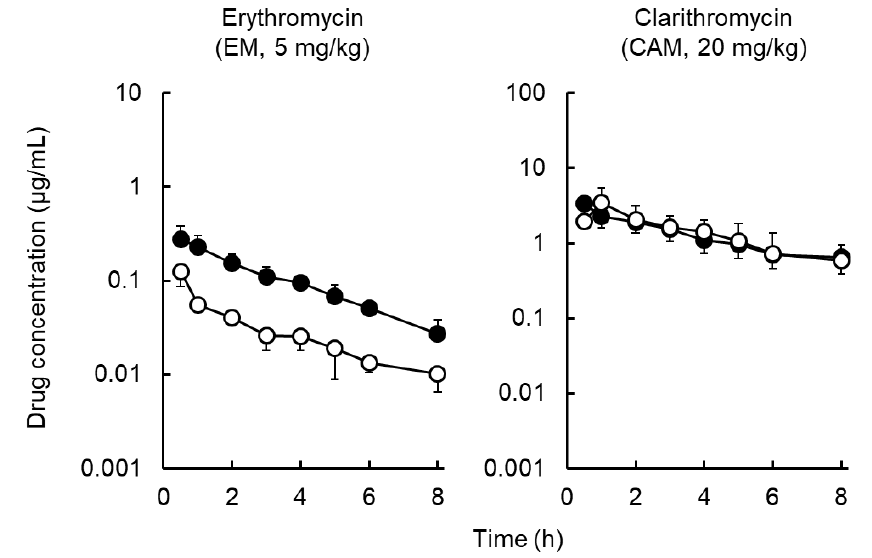
Figure 3. Total concentration profiles of erythromycin (EM) and clarithromycin (CAM) in plasma and interstitial fluid (ISF) after intravenous administration of EM (5 mg / kg) or CAM (20 mg / kg) to rats. (●) plasma; ( ○ ) ISF. Each symbol with a bar represents the mean ± S.D. for four to six rats.